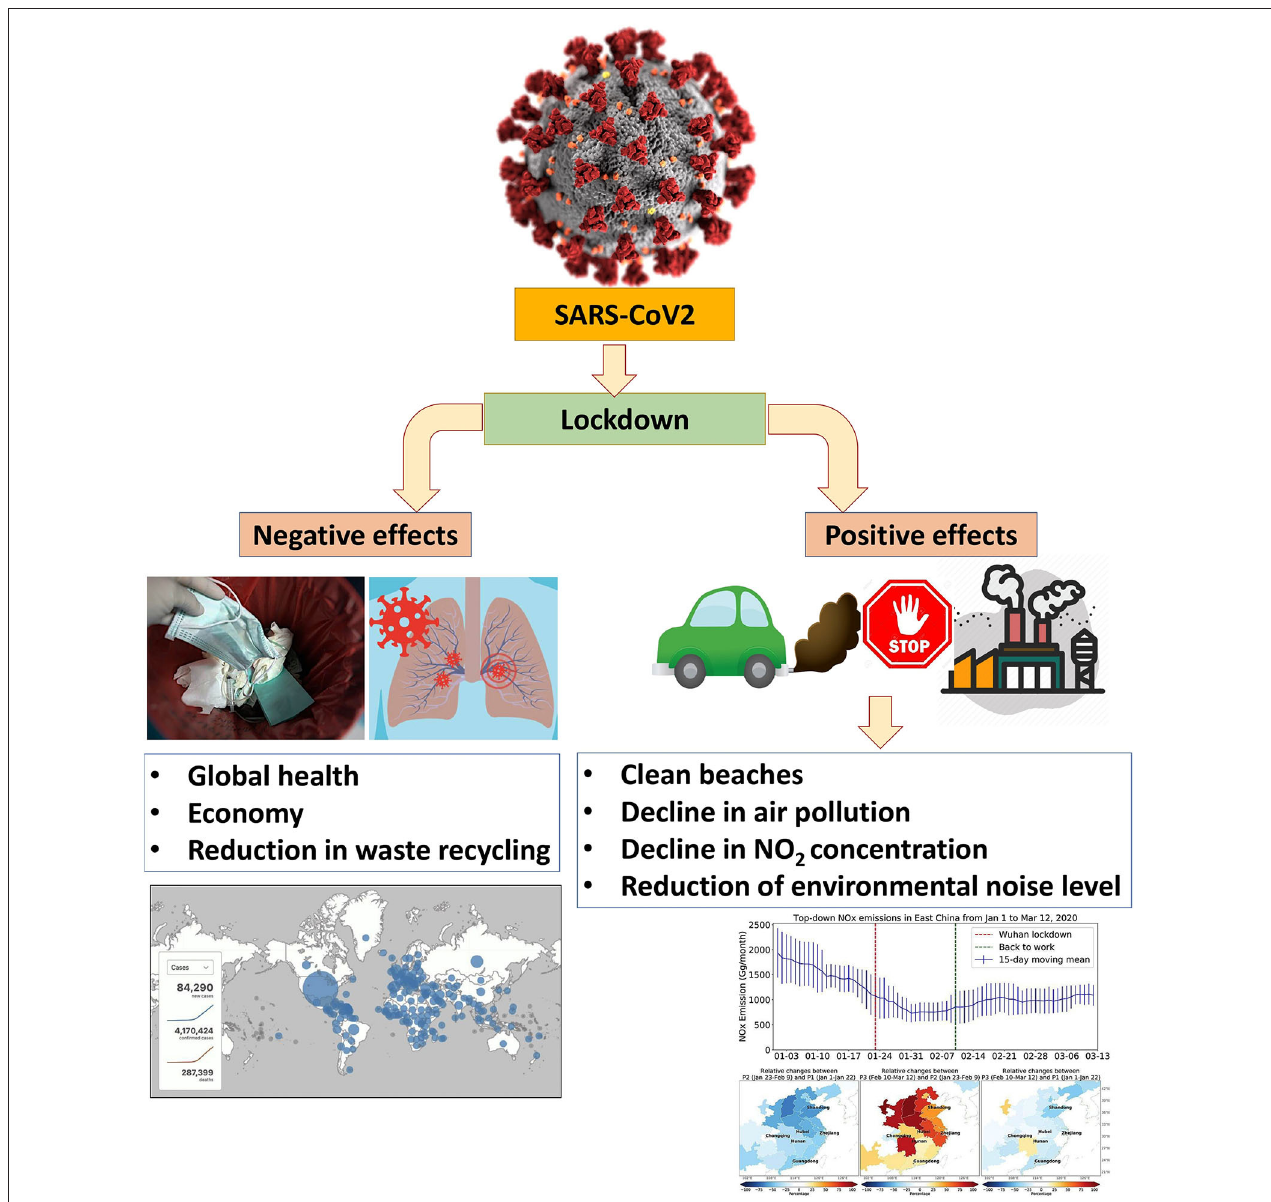
FIGURE 1 | The positive and negative effects of